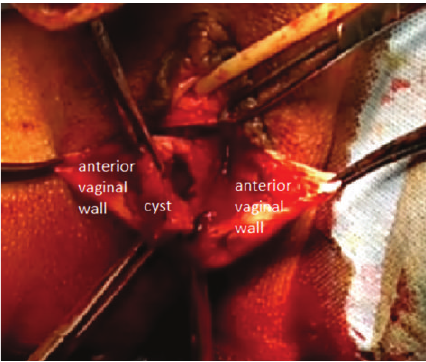
Figure 3: Surgical treatment with complete excision of the mass via a vaginal approach.